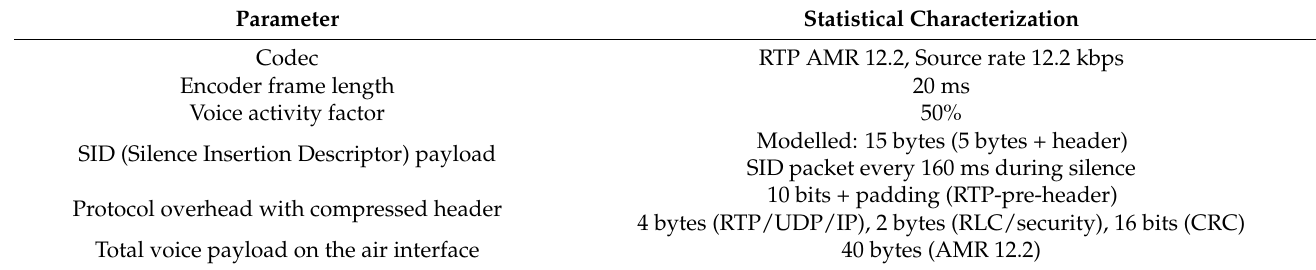
Table A3. VoIP traffic parameters.